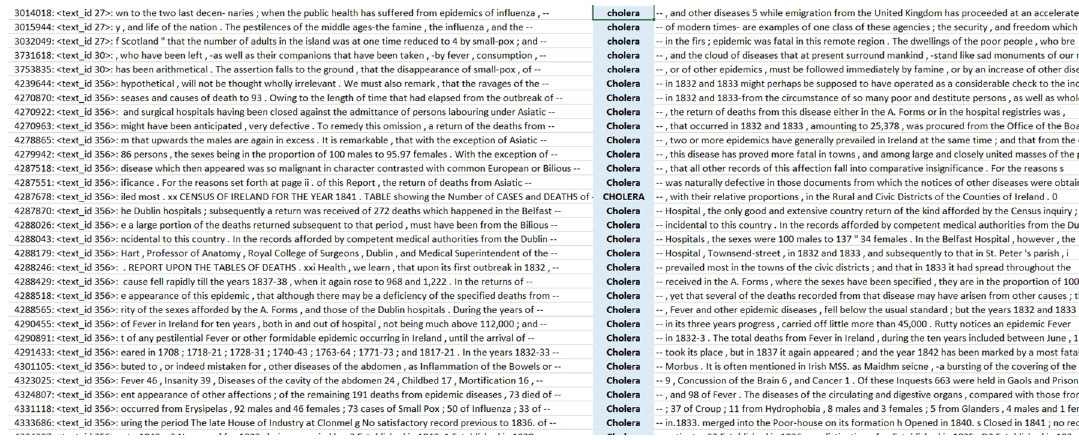
Figure 2: Sample of the co-text output created from the GCT.